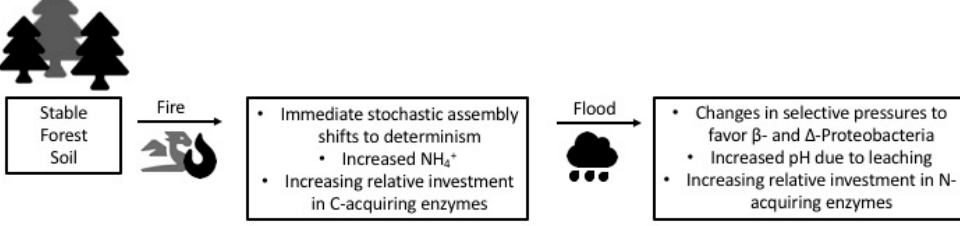
Figure 3. The proposed conceptual model synthesizes this research and previous work at this site, noting the mechanistic underpinnings of multiple, compounding disturbances on soil edaphic properties and bacterial community assembly process and function through secondary succession.